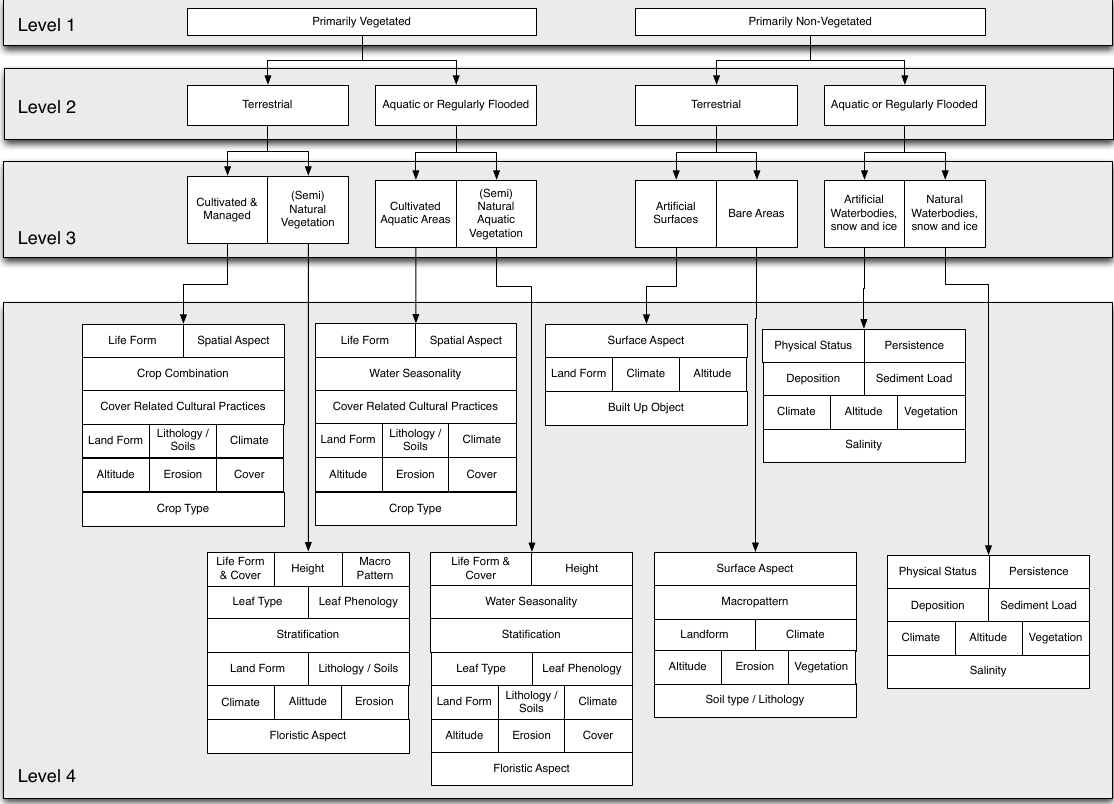
Figure 6. The hierarchical structure of Levels 1 to 4 of the Land Cover Classification Scheme (LCCS; [30]), implemented using the GEOBIA system proposed.